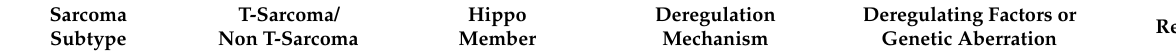
Table 1. Deregulation mechanisms of Hippo pathway in